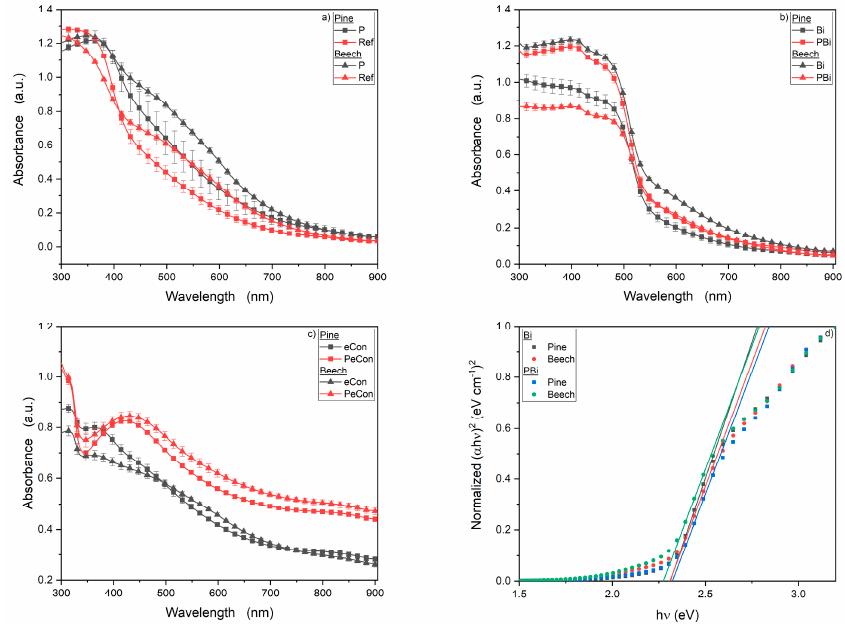
Figure 6. Absorbance spectra of coated and uncoated pine and beech wood: ( a ) reference and polyester coating, ( b ) coatings with bismuth oxide, ( c ) coatings with eCon ( d ) normalized band gap of the bismuth oxide existing layers ( n = 5).